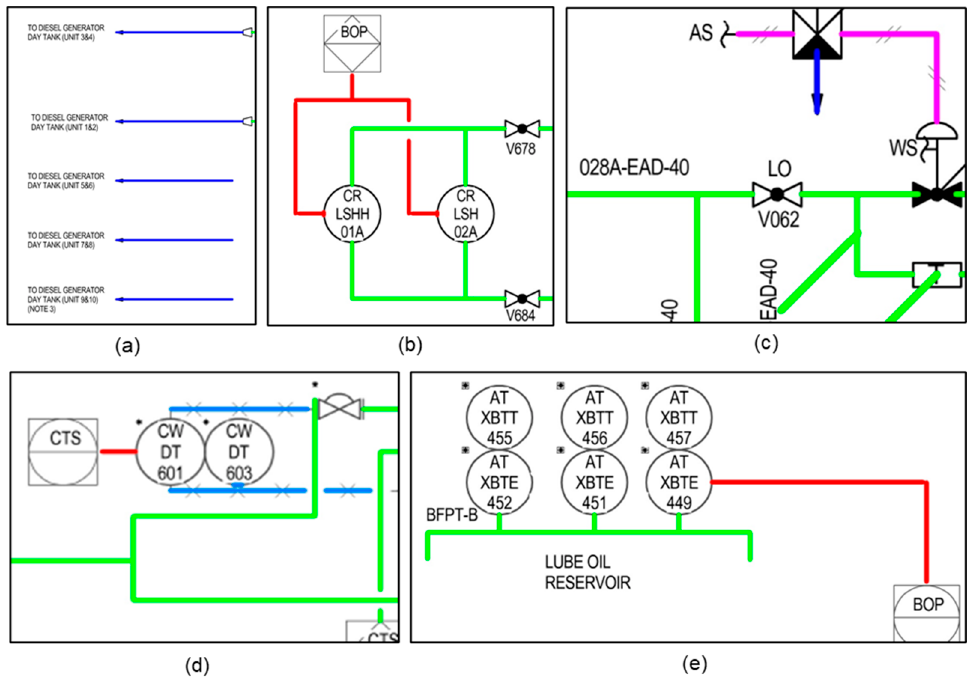
Figure 19. Line recognition results for test P&IDs. Table 1. Parameters of the deep neural network used for